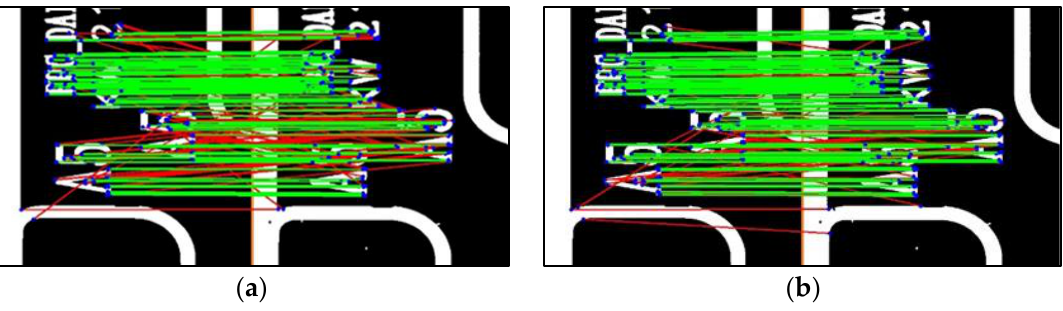
Figure 6. The effect of coordinate description on matching. Green and red lines refer respectively to correct and wrong matches. ( a ) ORB matching result. ( b ) ORB add coordinate descriptions matching result.